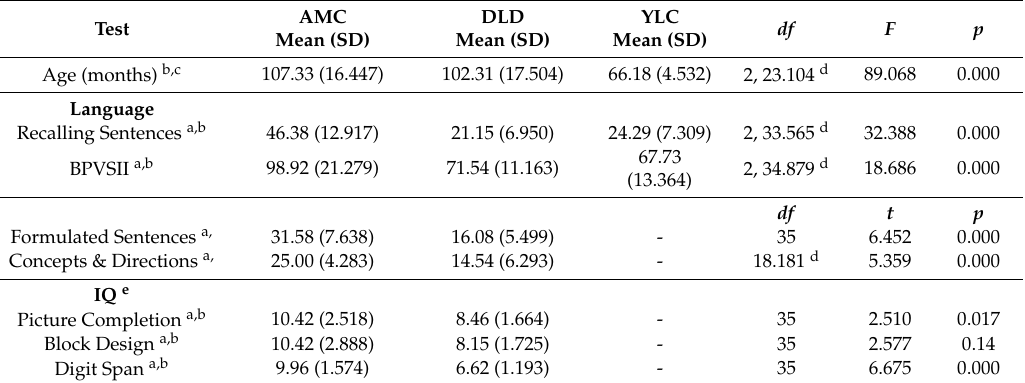
Table 1. Results of standardized tests by group (Language: raw scores; intelligence quotient (IQ): scaled scores): one-way ANOVAs and independent samples t